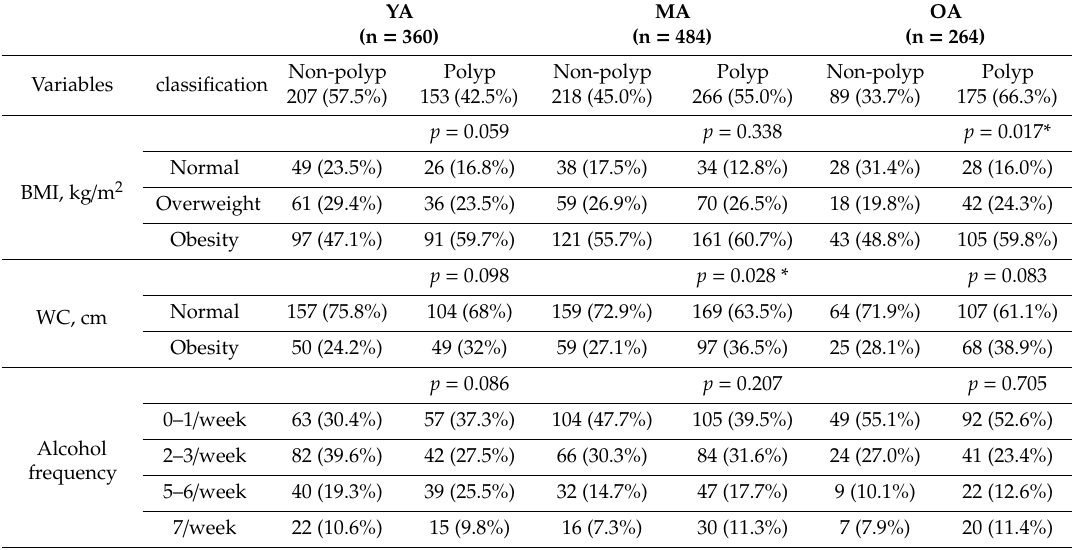
Table 2. Di ff erence of variables